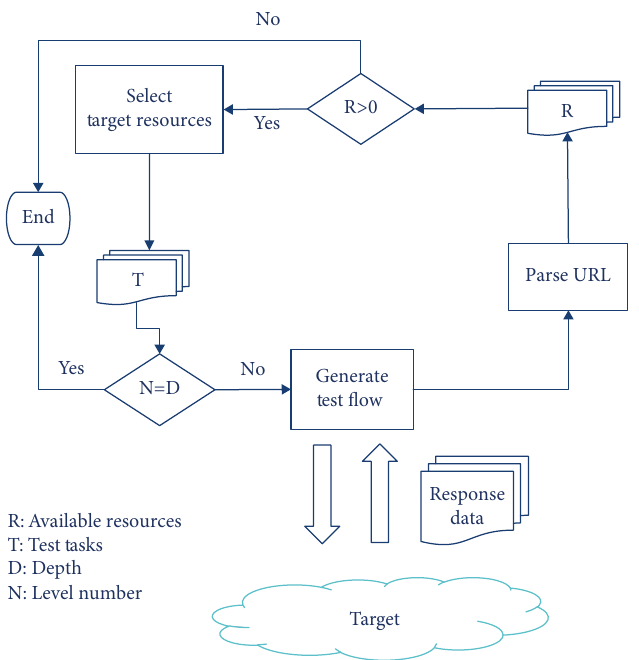
Figure 2: The work fl ow of the test node in the blanket mode.